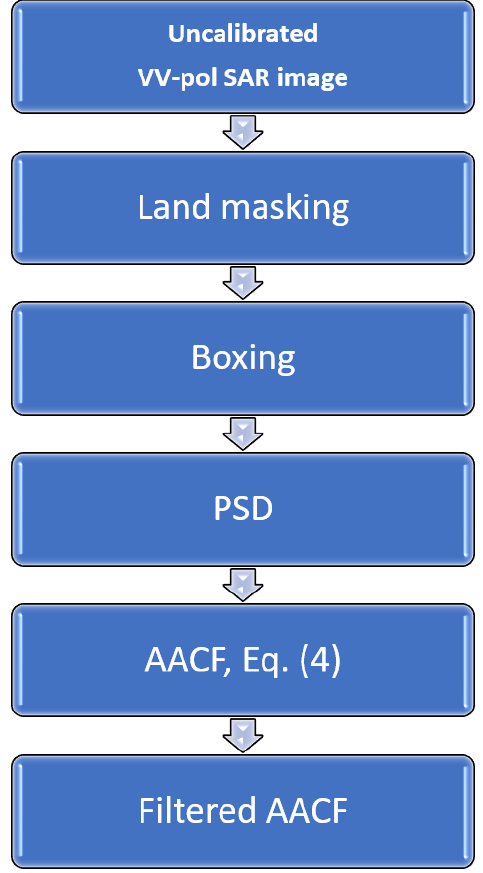
Figure 1. Flowchart of the AACF estimation